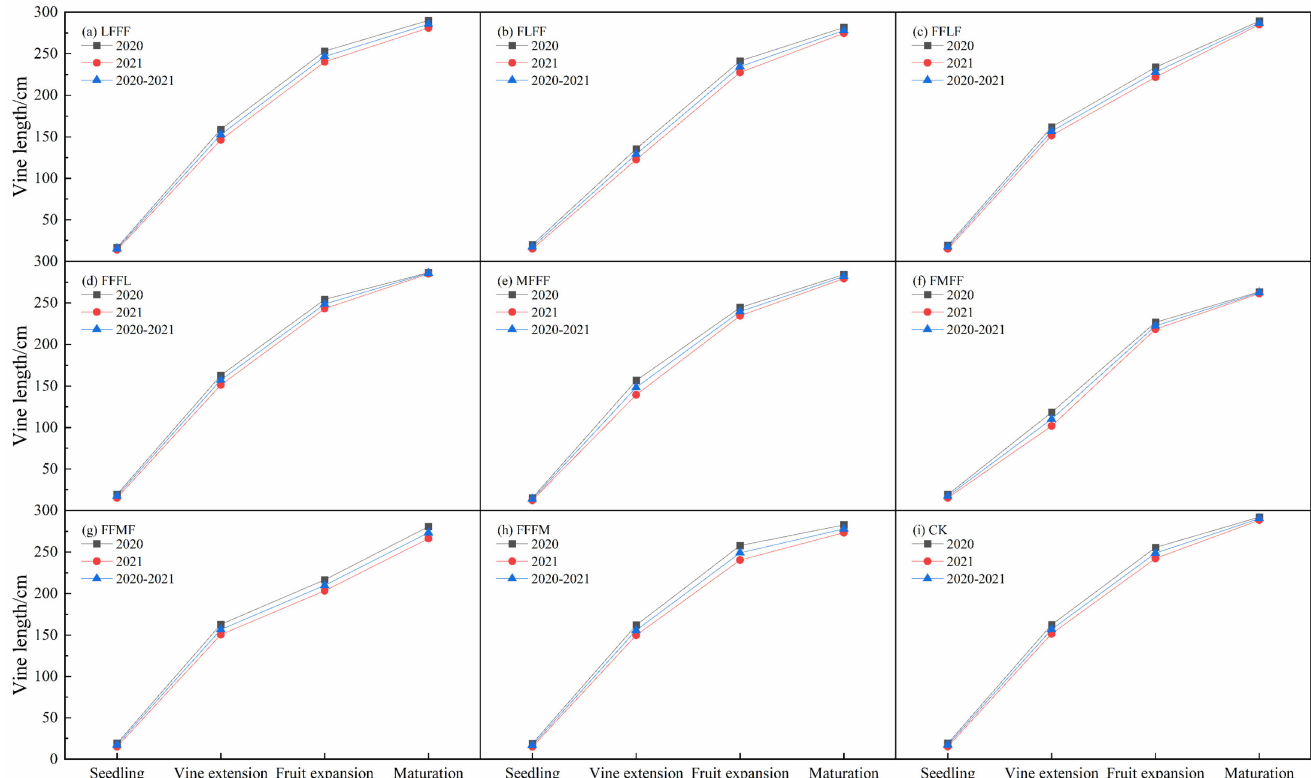
Figure 3. Effects of drip irrigation under mulch on the vine length of